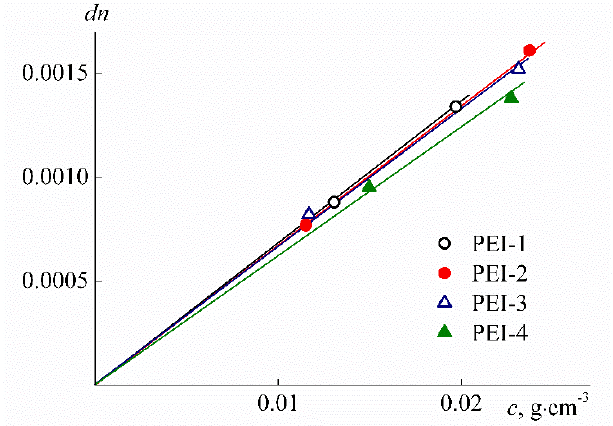
Figure 6. Concentration dependencies of the difference in refractive indices dn of the PEI-n solutions and chloroform.